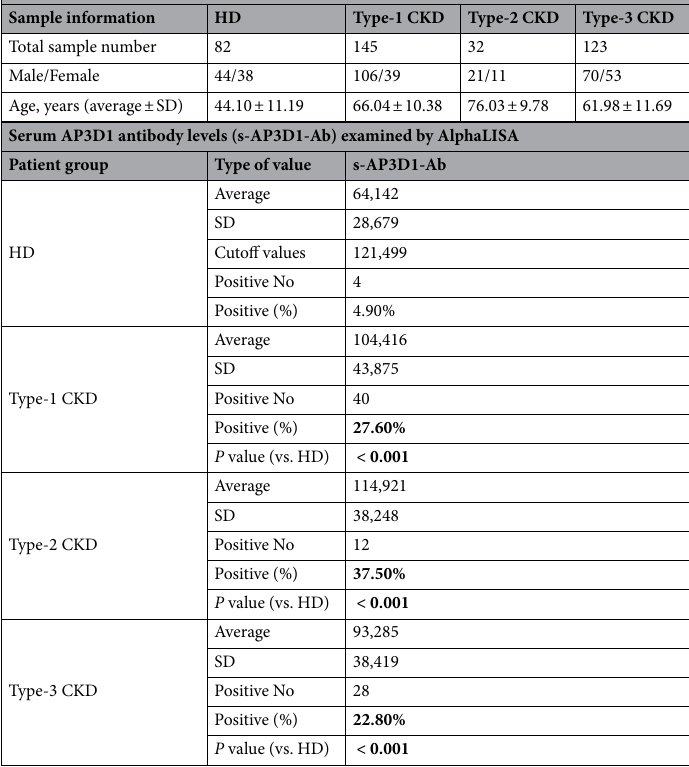
Table 4. Comparing the s-AP3D1-Ab levels between HDs and patients with chronic kidney disease (CKD). The numbers shown are as described in Table 1. CKD was divided into three groups as follows: type 1, diabetic kidney disease; type 2, nephrosclerosis; and type 3, glomerulonephritis. P values of < 0.05 and positive rates of > 10% are marked in bold font. The plots for these data are shown in Fig.